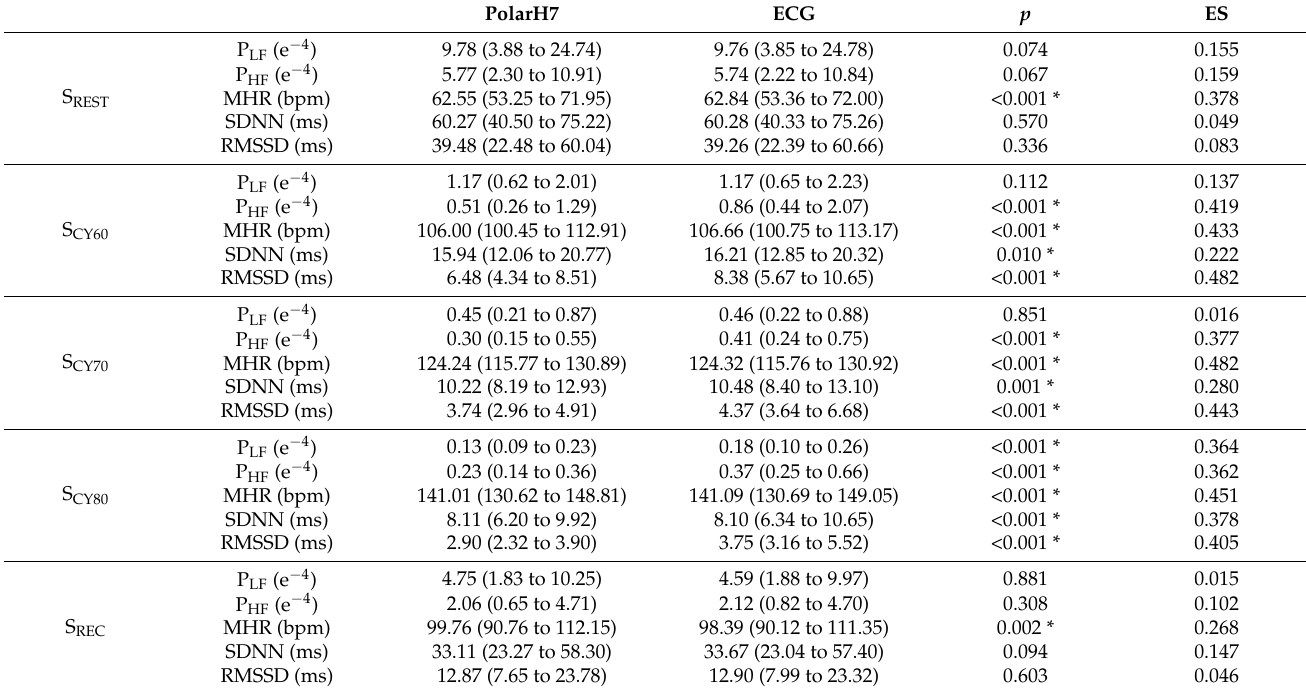
Table 3. HRV indices obtained from PolarH7 and ECG data ( n = 67).